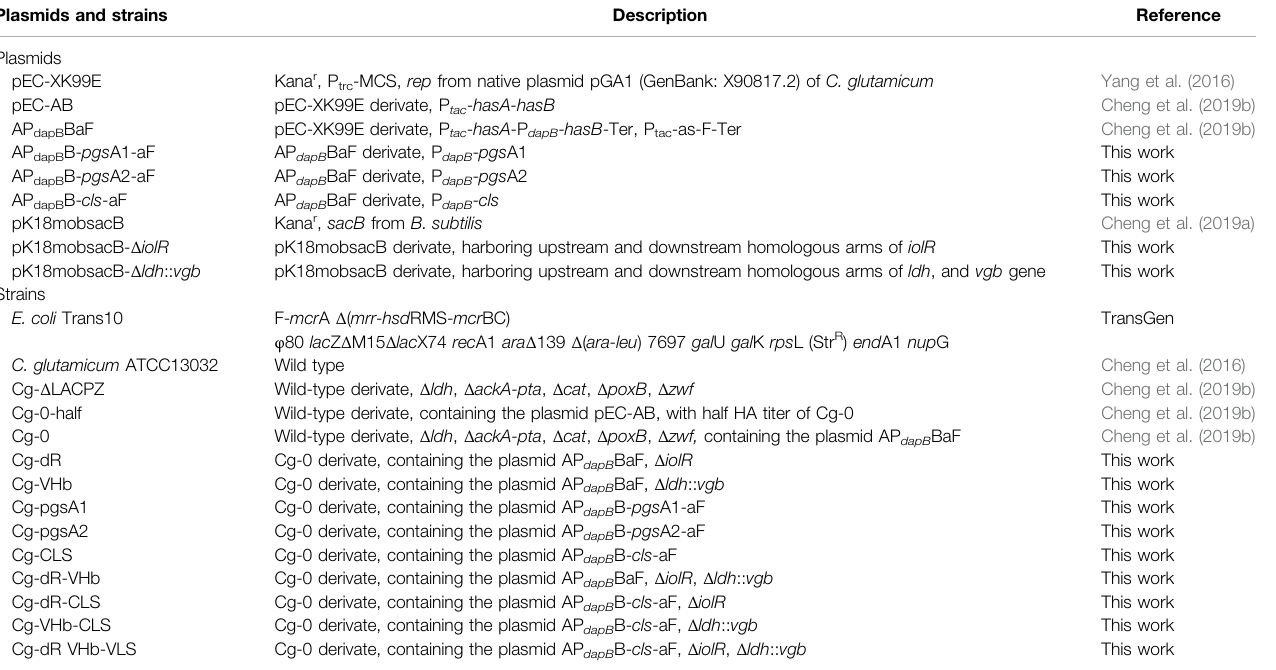
TABLE 1 | Plasmids and strains in this